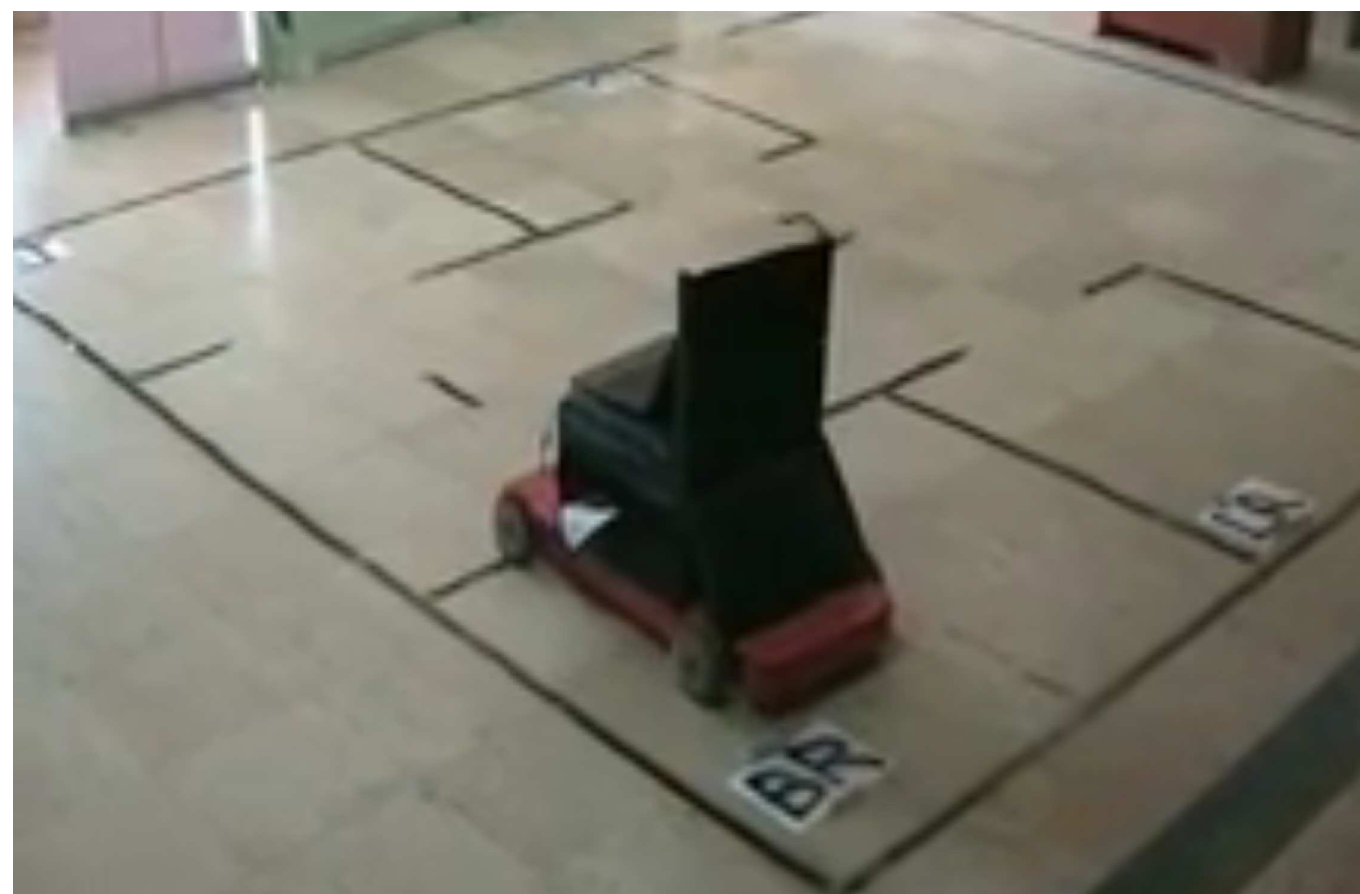
Fig 6. Driving from BR to